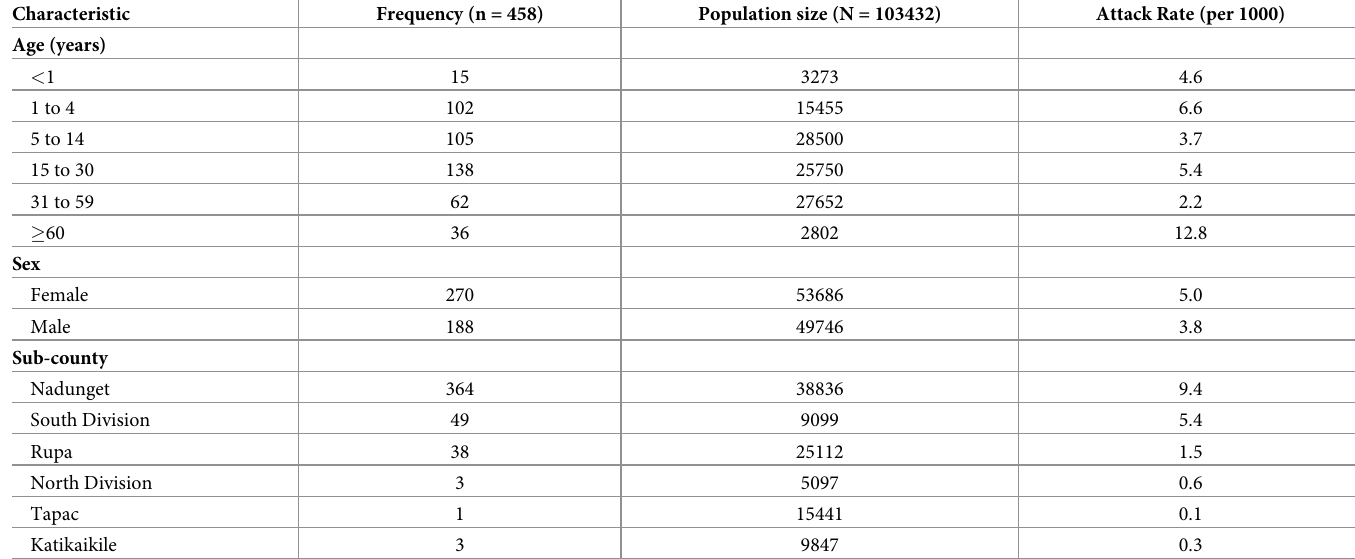
Table 2. Cholera attack rates by age, sex, and sub-county at Loputuk Health Center III, Nadunget Sub County, Moroto district, April to June 2020.